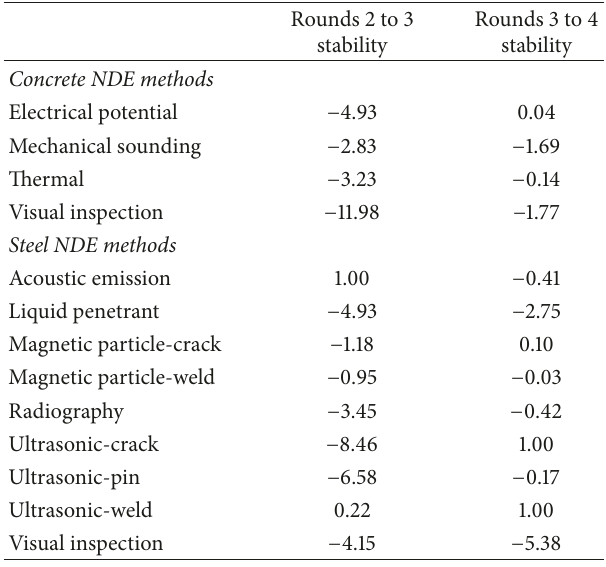
Table 4: True response stability results from the accuracy subsec- tion from round two through round